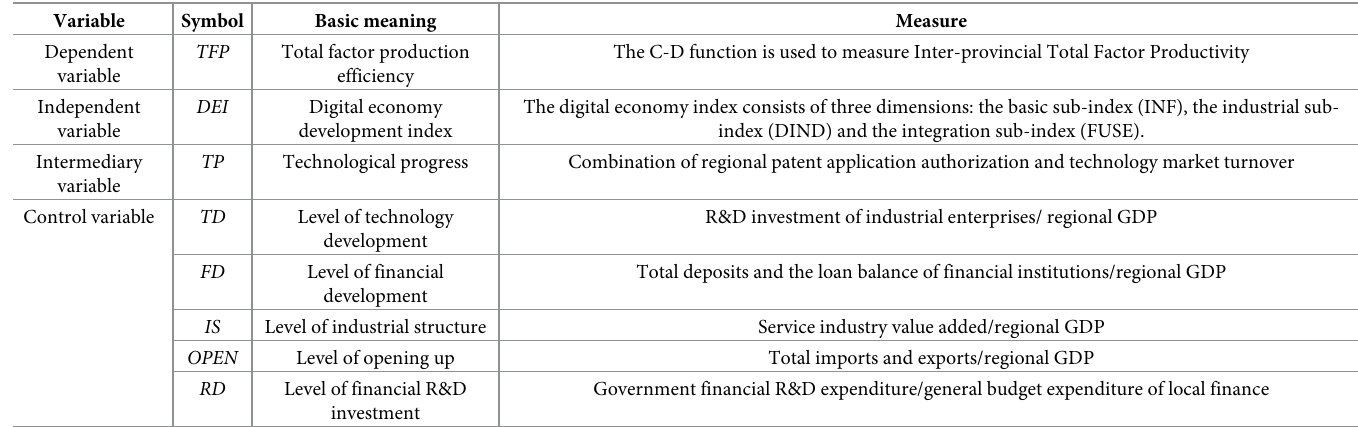
Table 4. Variable